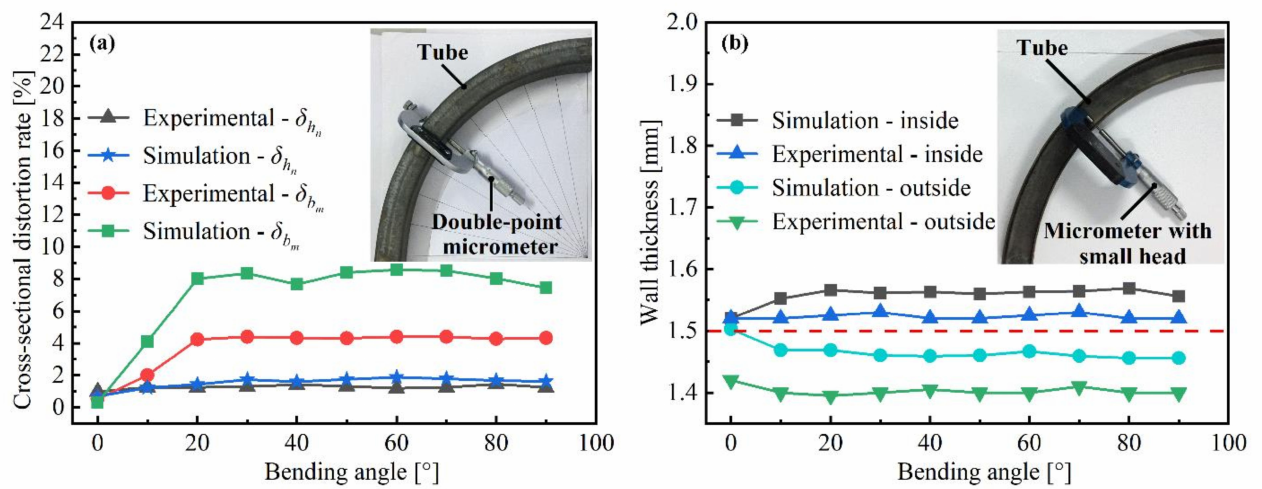
Figure 9. Comparison between the experimental and simulated results (feed rate of the tube: 10 mm/s; push speed of the bending roller: 1.5 mm/s; distance between the inductor and the bending roller: 50 mm): ( a ) cross-sectional distortion rate; ( b ) wall